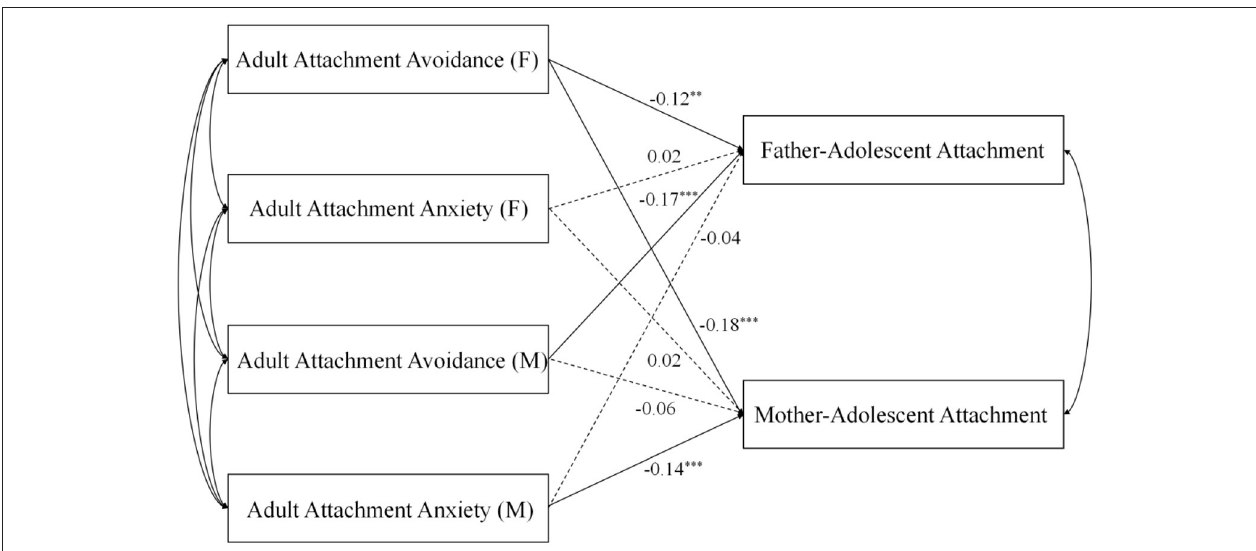
FIGURE 2 | Regression model. F, fathers; M, mothers. ** P < 0.01. *** P < 0.001.